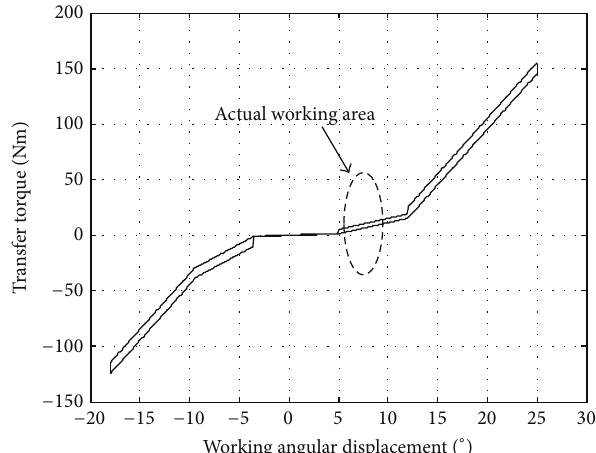
Figure 32: Nonlinear characteristics of a three-stage clutch damper.